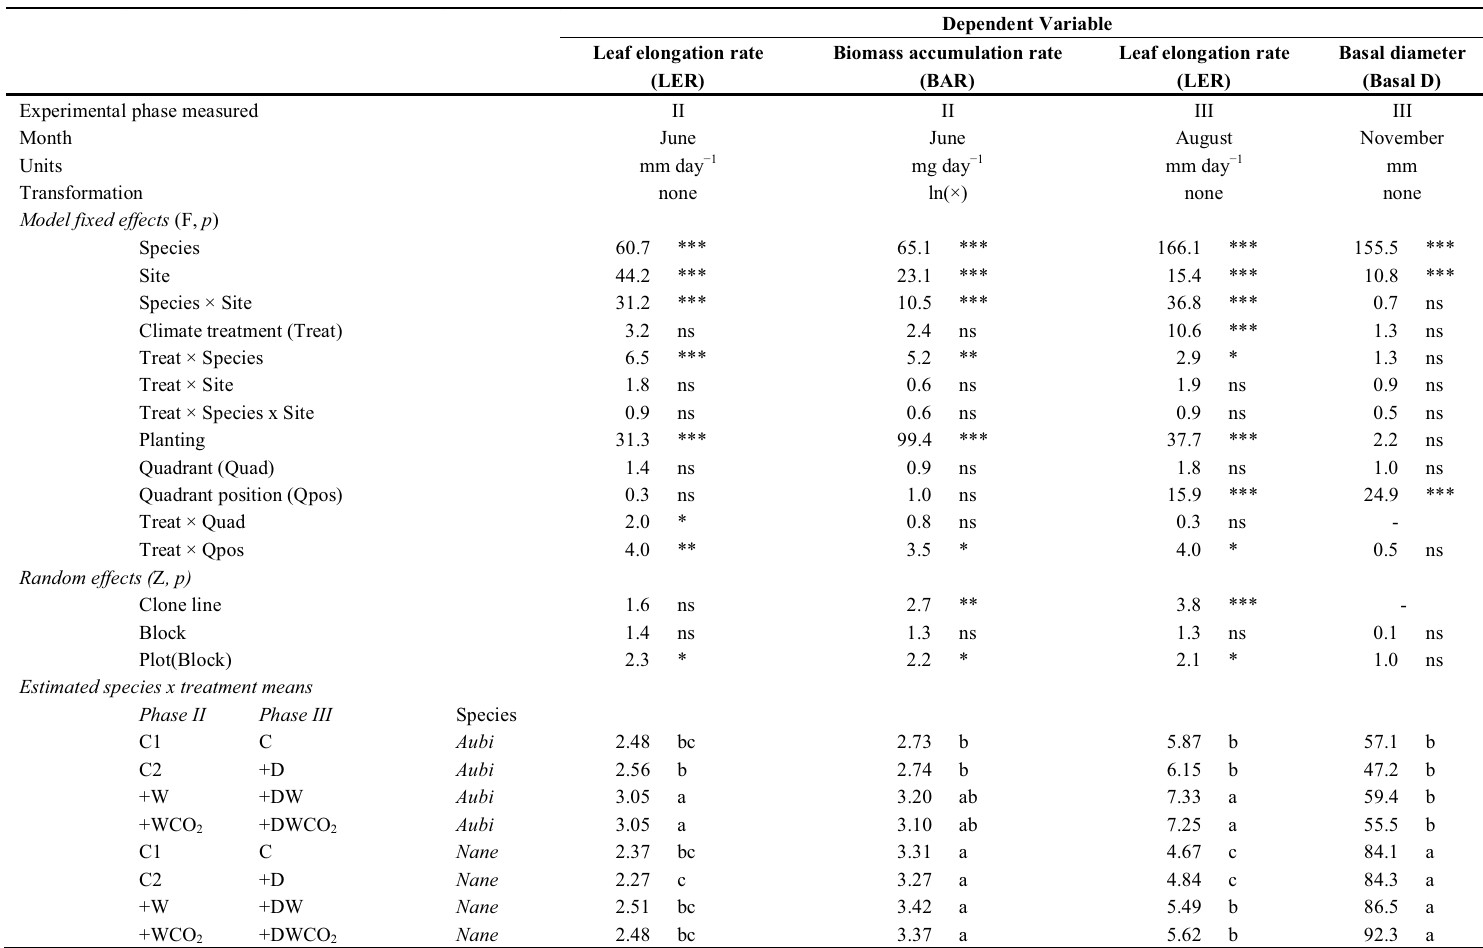
Table 3. Results of linear mixed model analysis of trait data collected during Phases II and III of the experiment. Climate treatment acronyms are provided in Figure 3. Columns adjacent to fixed variables contain F and associated p values (*** = p < 0.001; ** = p < 0.01; * = p < 0.05, ns = p (cid:149)(cid:3)(cid:19)(cid:17)(cid:19)(cid:24)(cid:12) ; for random variables Z and p are provided. Estimated means sharing the same letter did not differ at the 0.05 significance level. Only a restricted set of interactions involving quadrant and quadrant position are included; all others were not significant at the 0.05 significance level. Full model details are provided in the text. For species, Aubi = Austrostipa bigeniculata and Nane = Nassella neesiana